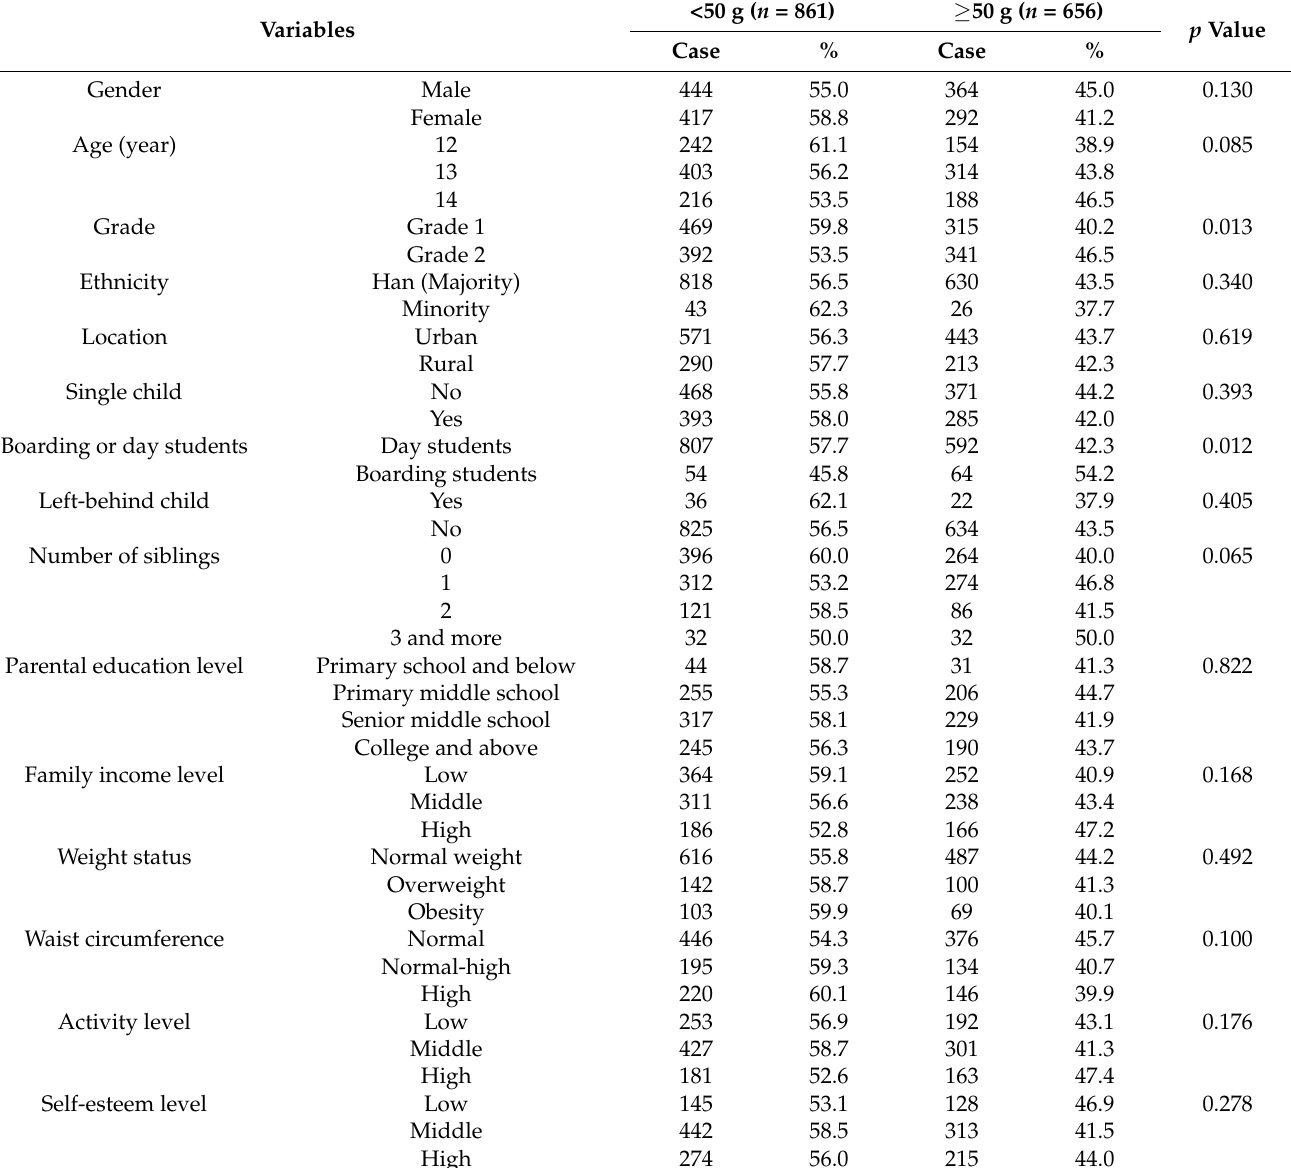
Table 1. Characteristics and free sugars consumption of participants ( n =